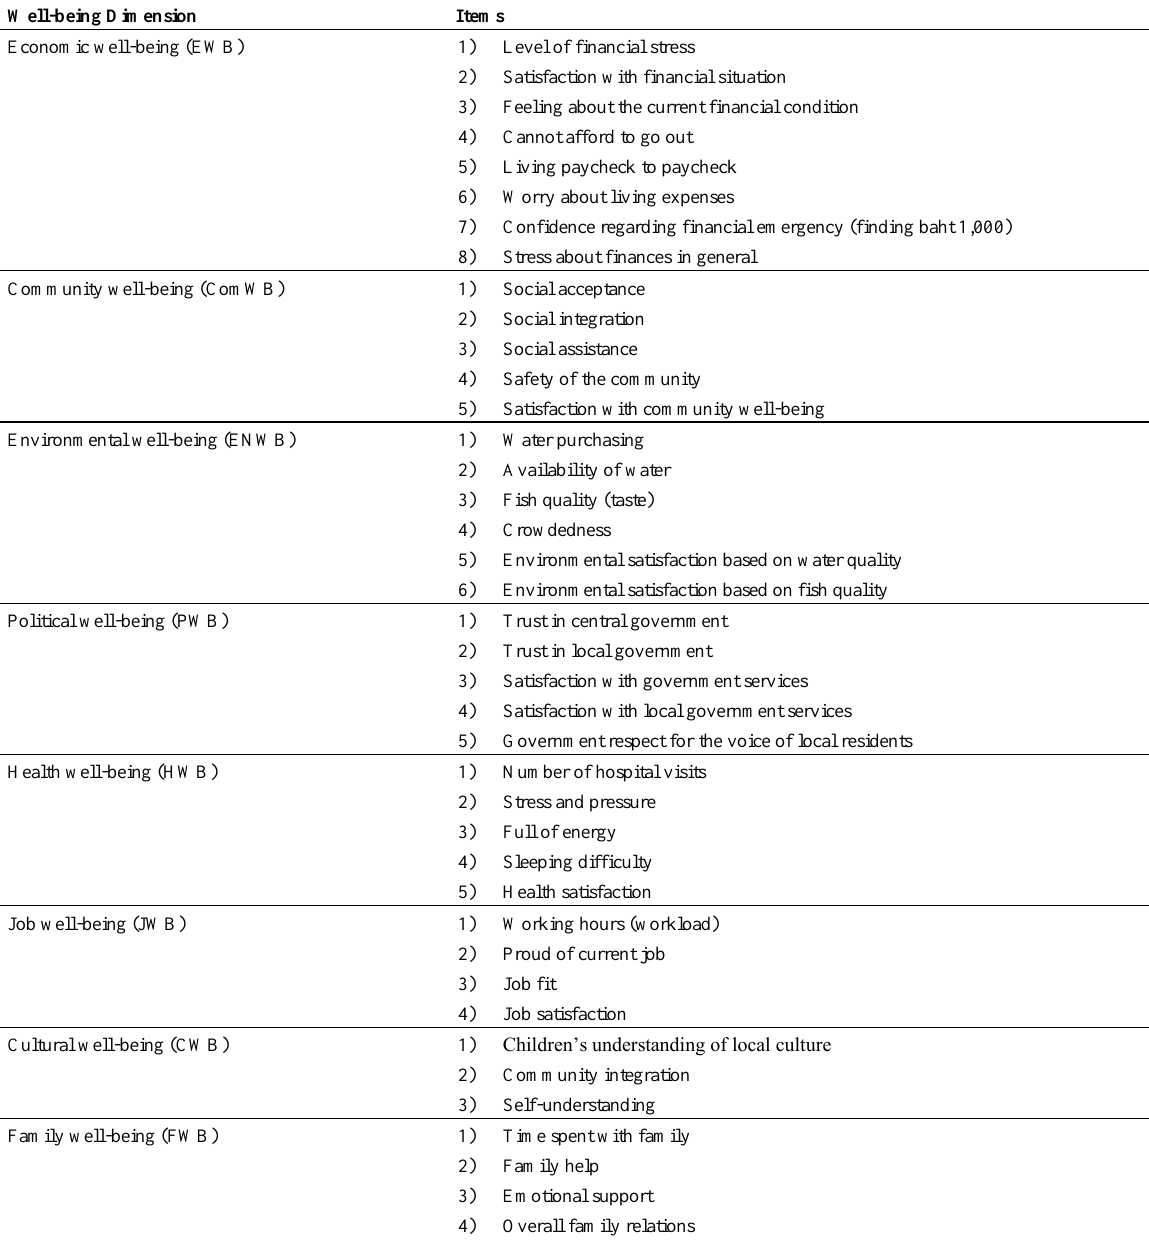
Table 1: Well-being dimensions with their